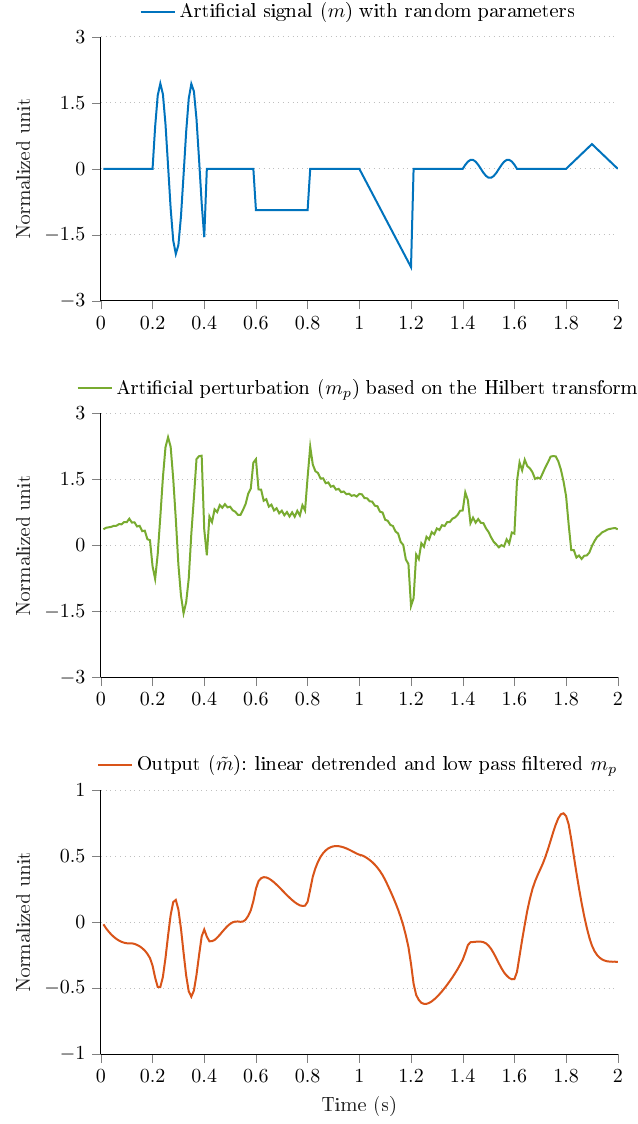
Figure 5. Artificial magnetic perturbation